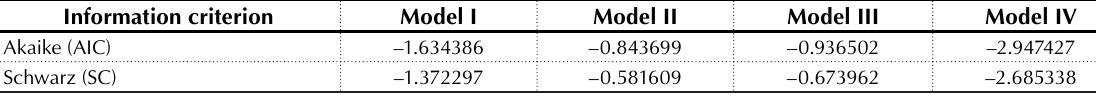
Table B1. The results of Akaike (AIC) and Schwarz (SC) tests